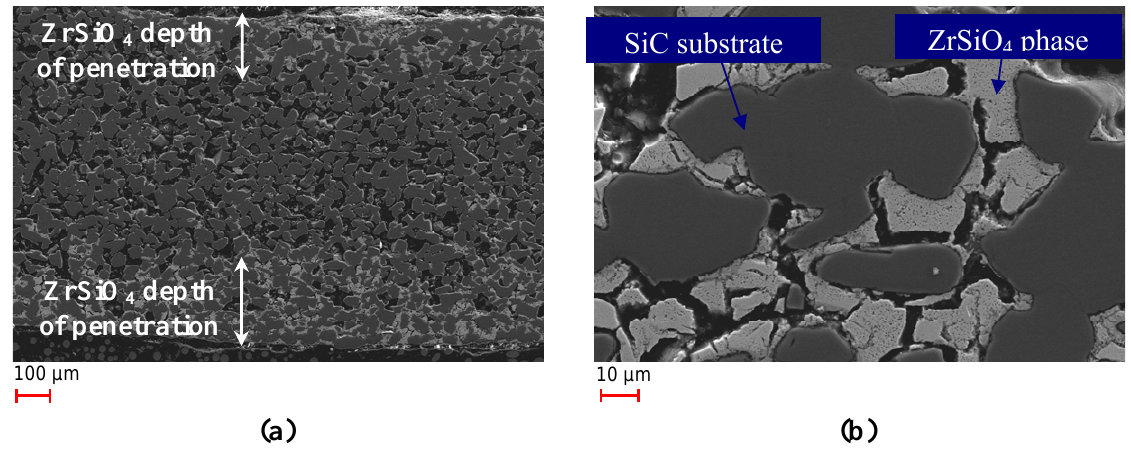
Figure 4. ( a ) SEM image of polished cross-section of Monolith 4 after 58 cycles ( b ) enlarged cutout of Figure